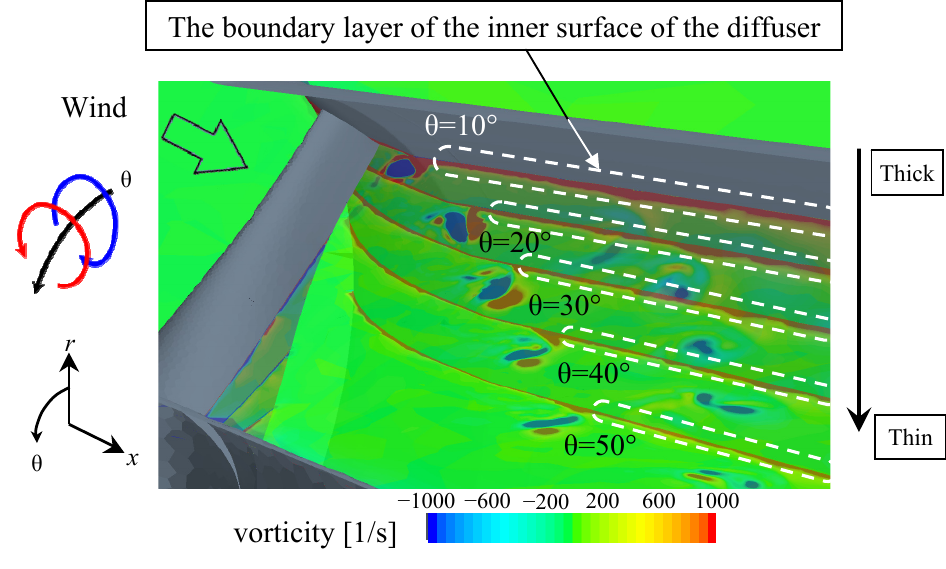
Figure 11. θ -component of the vorticity inside the long-type Wind-Lens turbine including that of the blade tip vortex and the counter-rotating